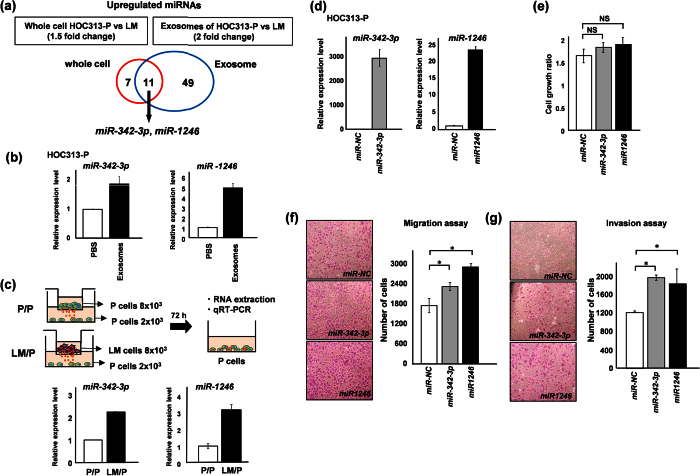
LM-exosomes contain oncogenic miRNAs and mediate their transfer to promote intercellular communication.(a) The Venn diagram illustrates the overlapping result of differentially expressed miRNAs in whole cells and exosomes, including HOC313-P and HOC313-LM cell comparisons. Two miRNAs, miR-342-3p and miR-1246, were upregulated in both whole cells and exosomes. (b and c) MiR-342-3p and miR-1246 were transferred to HOC313-P cells treated with LM-exosomes (b) or across a Transwell membrane through exosomes (c). (d) Validation of miR-342-3p and miR-1246 expression after each miRNA transfection in HOC313-P cells was measured by qRT-PCR. MicroRNA expression levels were normalized to RNU6B expression. MicroRNA expression levels of miR-342-3p (left) and miR-1246 (right) relative to the negative controls are shown. (e) Cell growth after 72 hours of transfection with miR-342-3p, miR-1246 and miR-NC in HOC313-P cells was evaluated by WST-8 assay. (f and g) Cell motility was assessed by Transwell migration assay (f) and cell invasion was assessed by Transwell invasion assay (g) in HOC313-P cells transfected with miR-342-3p or miR-1246. Experiments were performed in triplicate. (Bars, SD). Student’s t-test was used for statistical analysis; asterisks represent P < 0.05 versus each control transfectant.